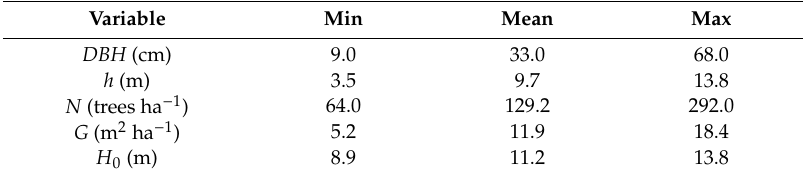
Table 1. Summary information of the tree- and plot-level ground